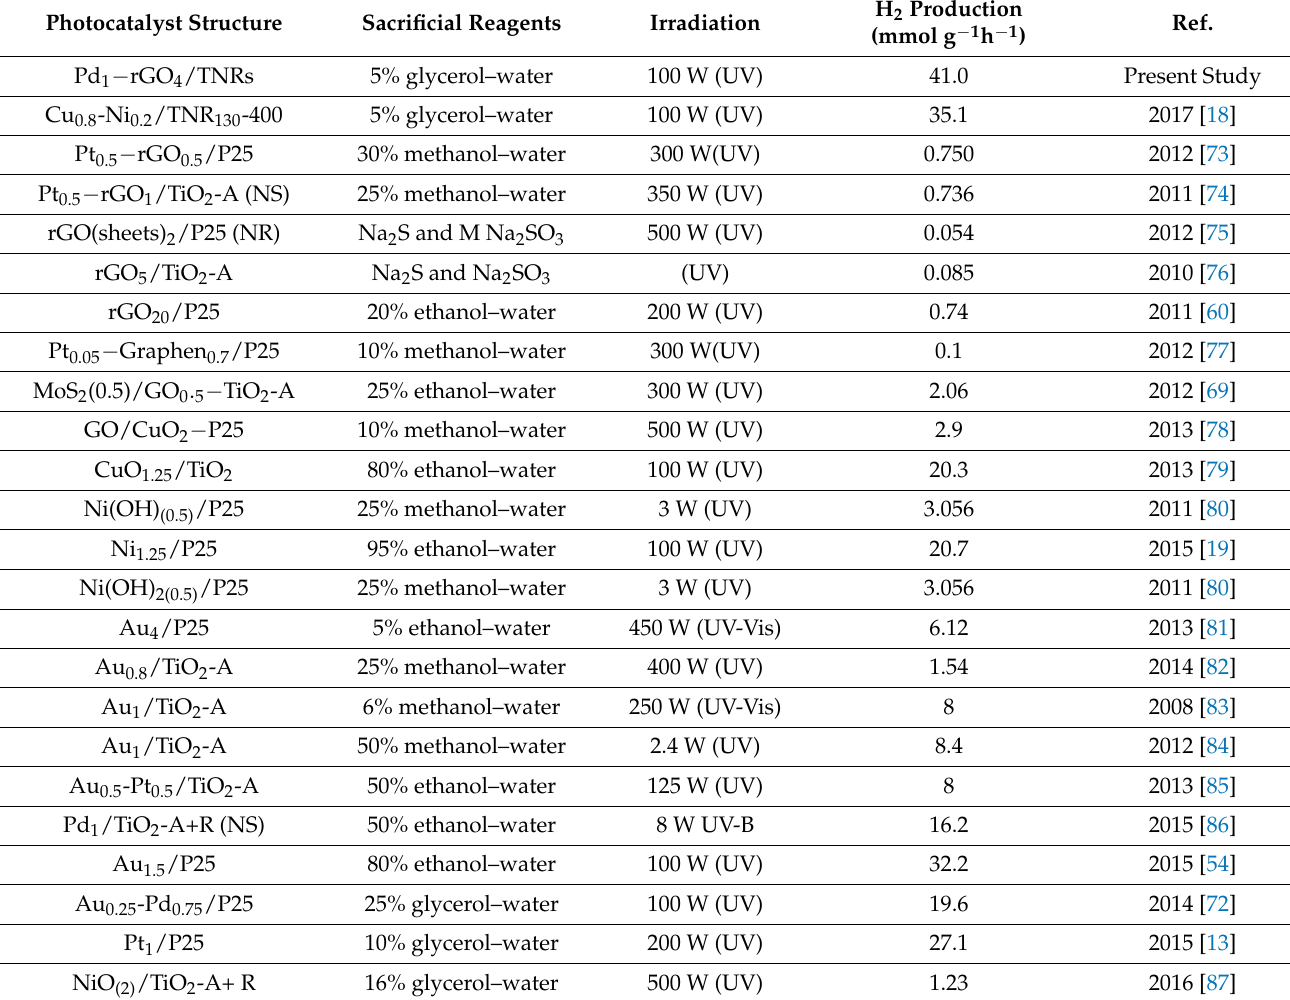
Table 1. Comparison of hydrogen production rates on metal-supported TiO 2 catalysts. The subscripts with metal and graphene indicate their wt.% with respect to oxide support. (A = anatase; R = rutile; NR = nanorods; NS = nanosheets; NF =